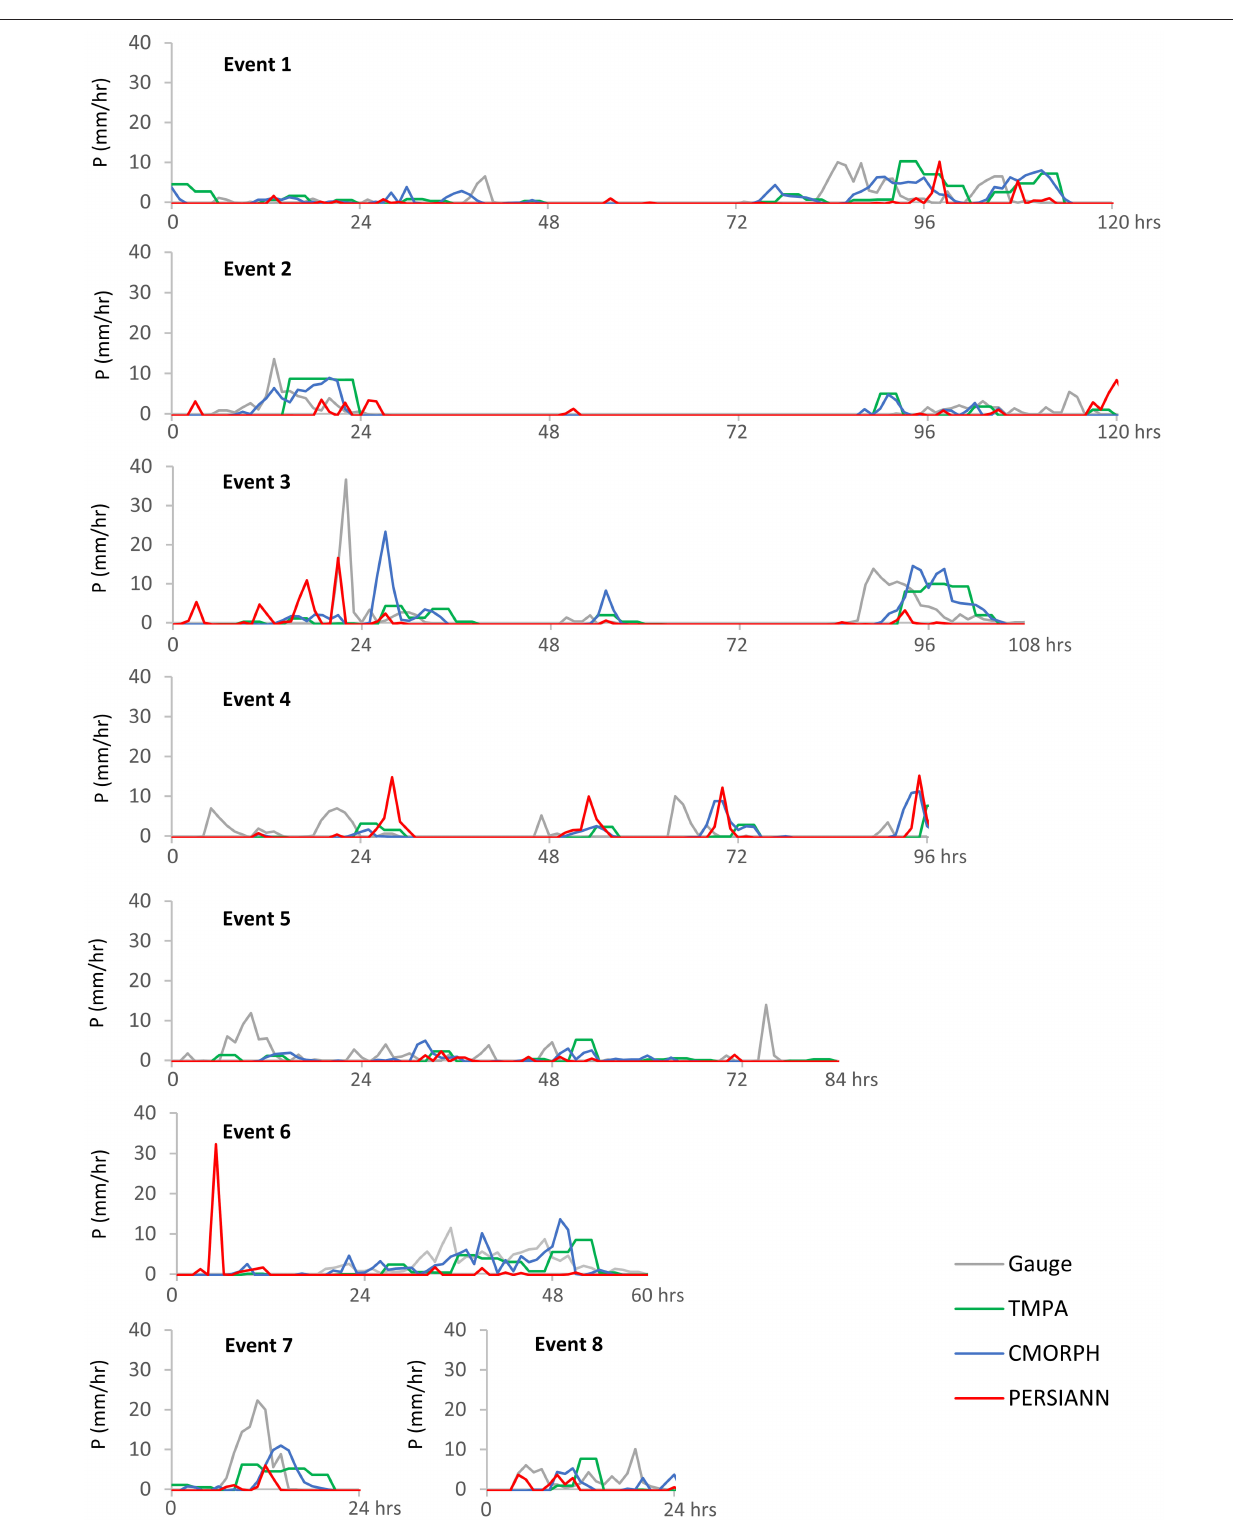
Frontiers in Environmental Science |